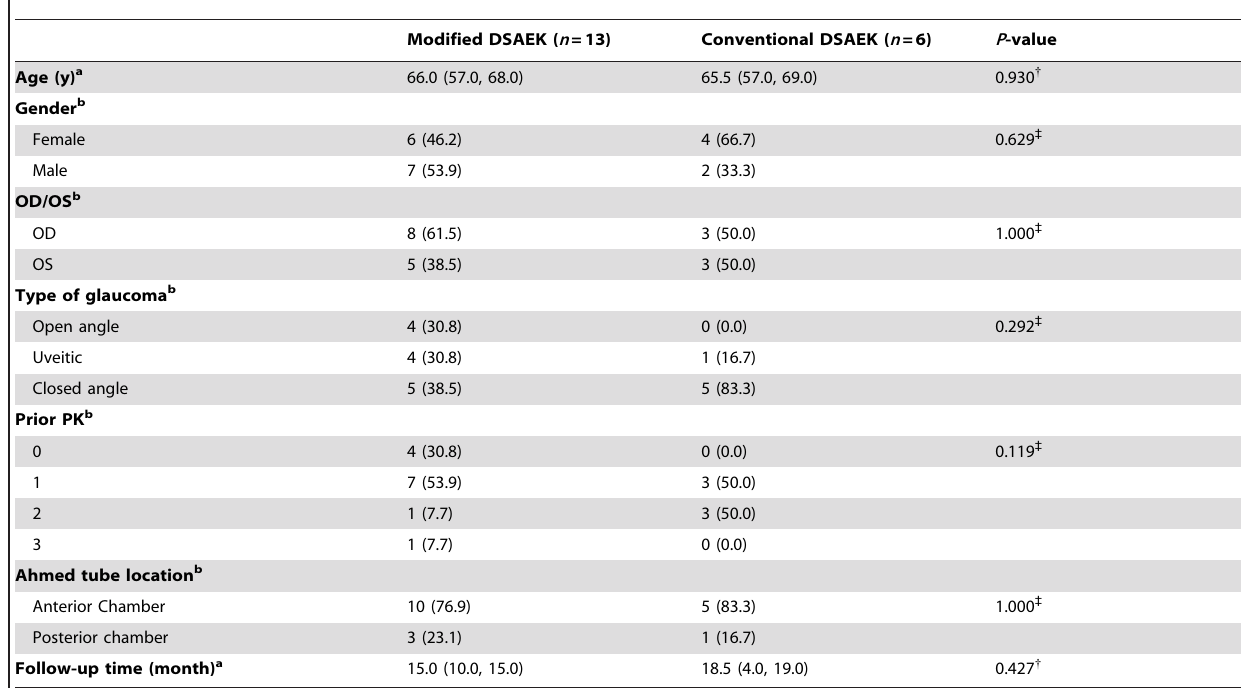
Table 1. Characteristics of patients who received modified DSAEK and those who received conventional DSAEK.